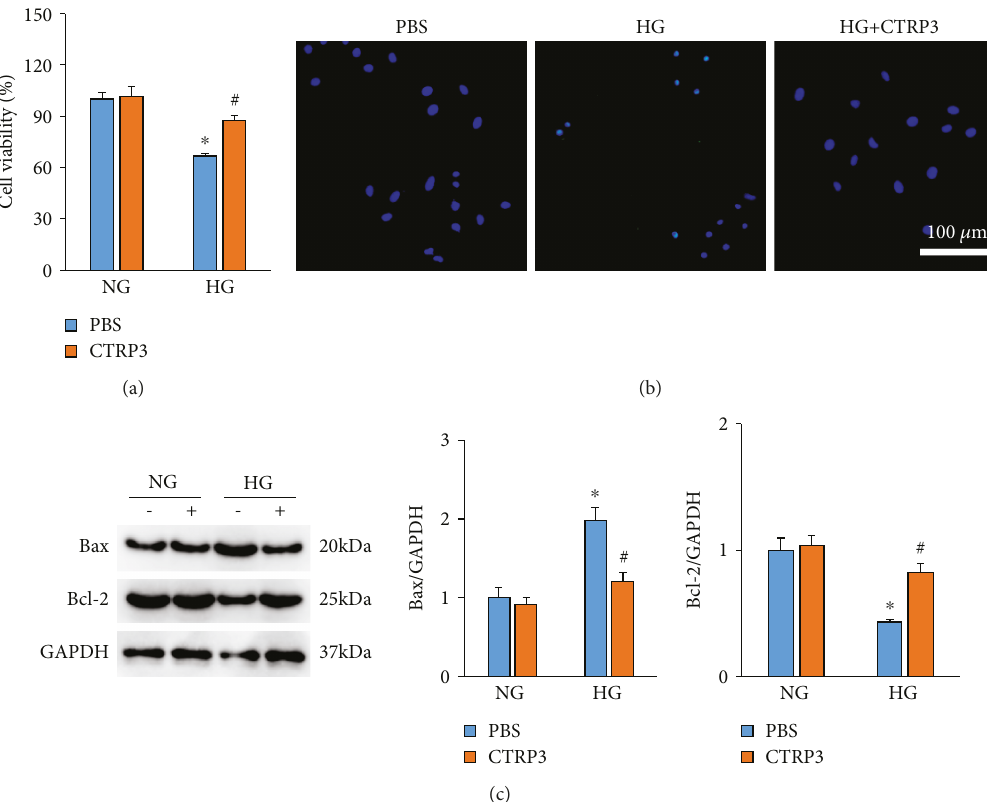
Figure 3: CTRP3 reduces the level of apoptosis in HUVECs induced by high glucose. (a) Cell viability in HUVECs induced by high glucose ( n = 5 ). (b) Cell apoptosis as detected by TUNEL staining. (c) The protein expression of Bax and Bcl-2 was detected by western blot analysis ( n = 5 ). Data are expressed as mean ± SD of fi ve independent experiments. ∗ P < 0 05 when compared to the NG group; # P < 0 05 when compared to the HG